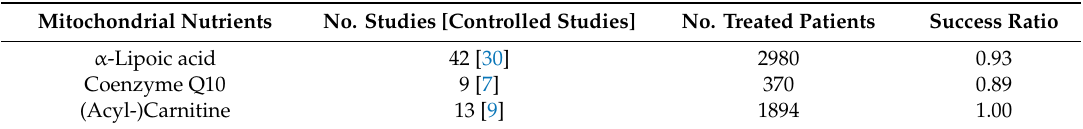
Table 1. Reported clinical trials testing adjuvant administration of mitochondrial nutrients (MNs) in Type 1 and Type 2 diabetic patients (reviewed in